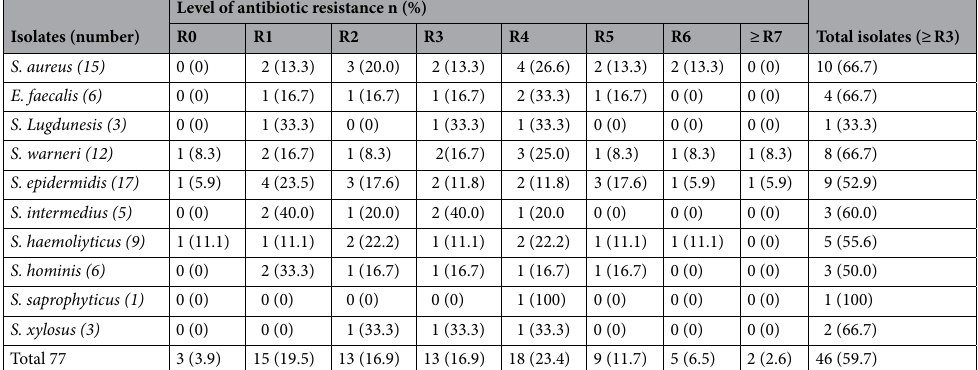
Table 6. The multi-drug resistance level of blood-born Gram-positive bacteria. R0 resistance to no antibiotics, R1 resistance to one antimicrobial category, R2 resistance to two antimicrobial categories, R3 resistance to three antimicrobial categories; R4 , resistance to four antimicrobial categories R5 resistance to five antimicrobial categories, R6 resistance to six antimicrobial categories, resistance ≥ 7 resistance to seven antimicrobial categories, ≥ R3 nonsusceptibility to at least one agent in 3 or more classes of antibiotics.